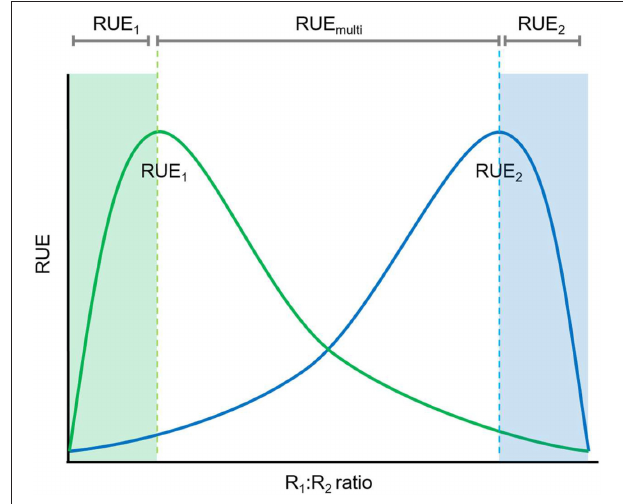
FIGURE 4 | Relationships between resource ratio and RUE under multiple resource limitation. Under conditions when one resource is limiting (either high or low R 1 :R 2 ratio) RUE can be determine based on a single resource (either R 1 , green shaded area, or R 2 , blue shaded area) whereas multiple resource limitations need to be considered for the determination of RUE if both resources are in higher supply (more